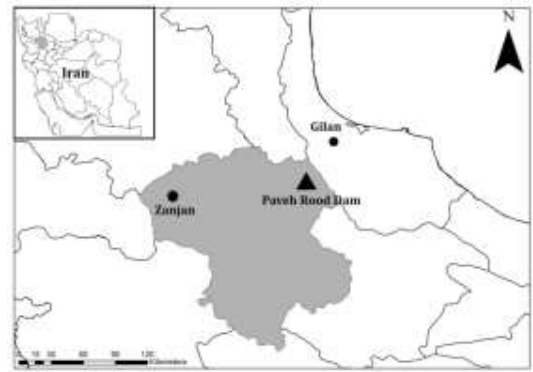
Figure 1. Location of Paveh Rood Dam in